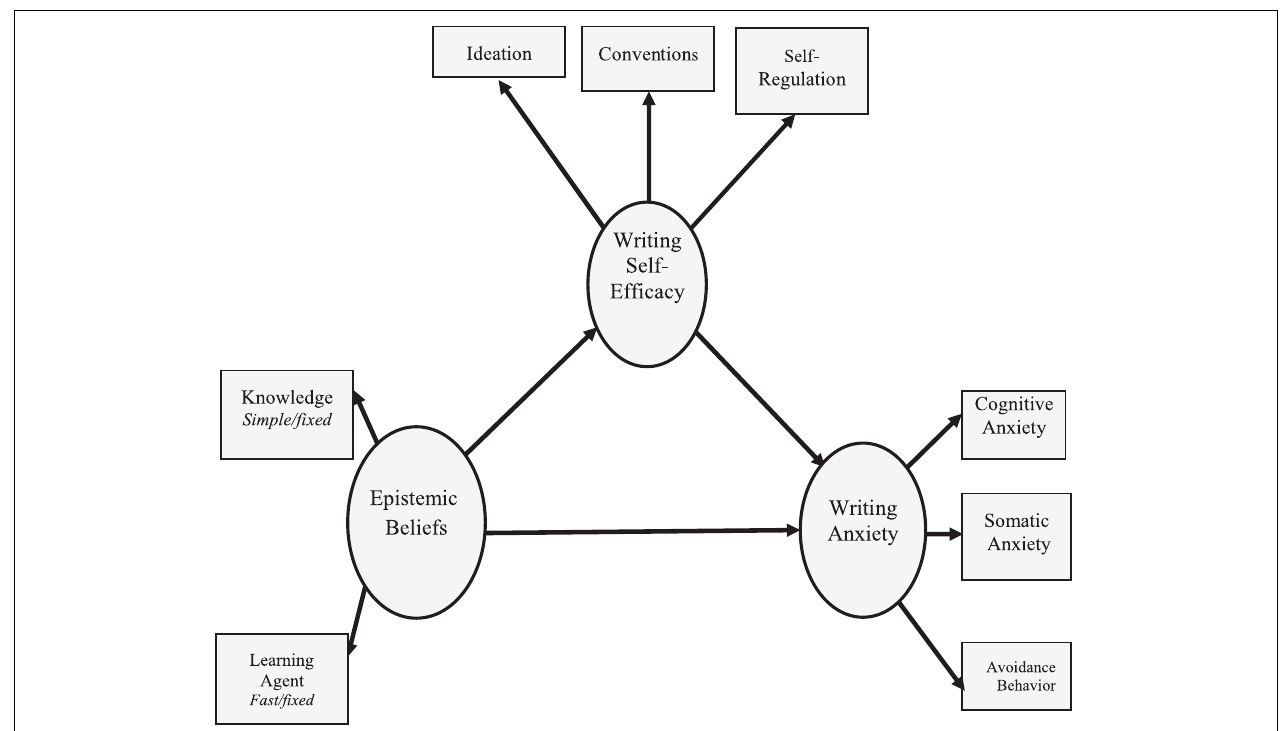
FIGURE 1 | The hypothesized structural equation modeling (SEM) model and the causal paths among the